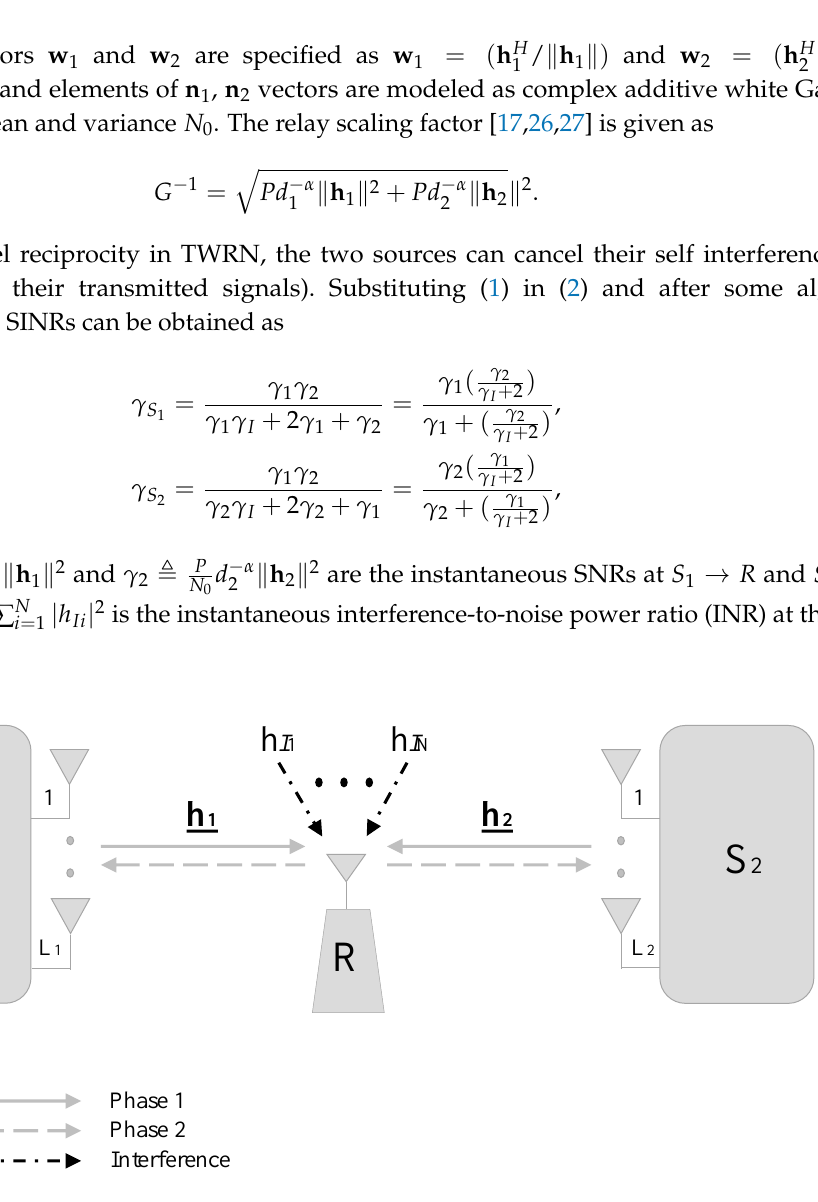
Figure 1. Block diagram of TWRN with maximal ratio transmission and CCI at the